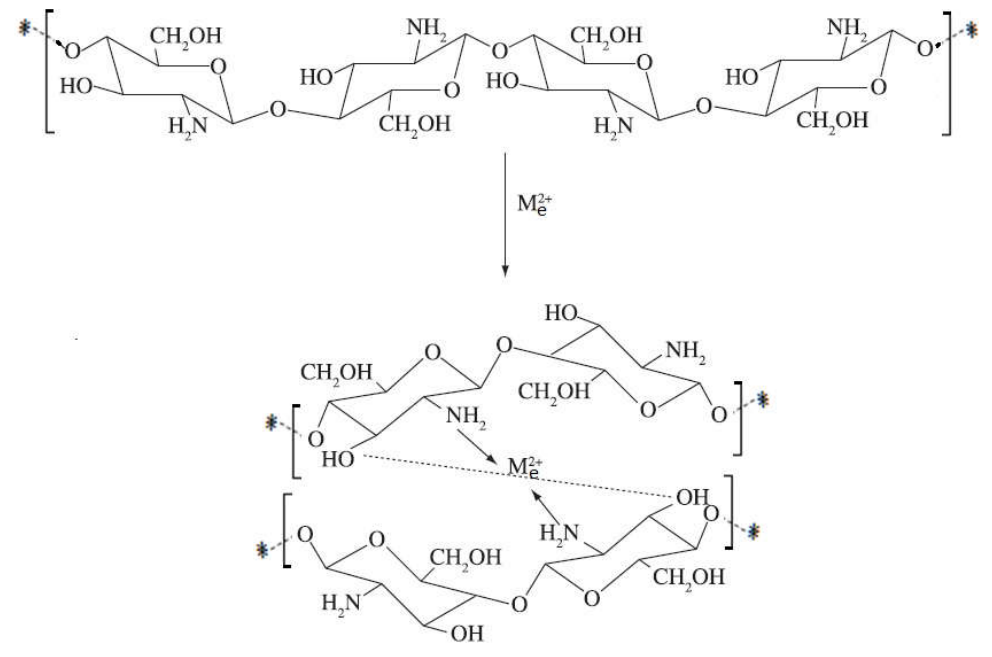
Figure 21. Schematic chitosan chelation with metal ions, according to [81]. The structure of chitosan–metal complexes depend on the chitosan/metal ion molar ratio [120], type of metal ion, molecular weight of chitosan, degree of deacetylation of chitosan, zeta potential [133] of the loaded ion nanoparticles, as well as on the working conditions